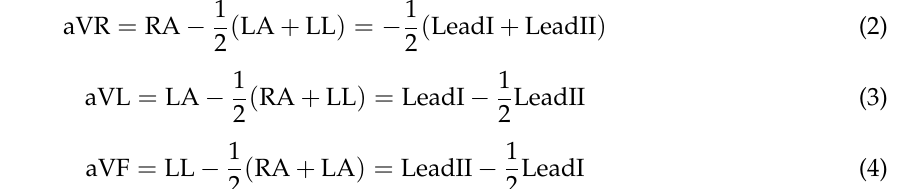
Figure 2. ( a ) A basic scheme and ( b ) the equivalent electrical model of a used noncontact electrode.